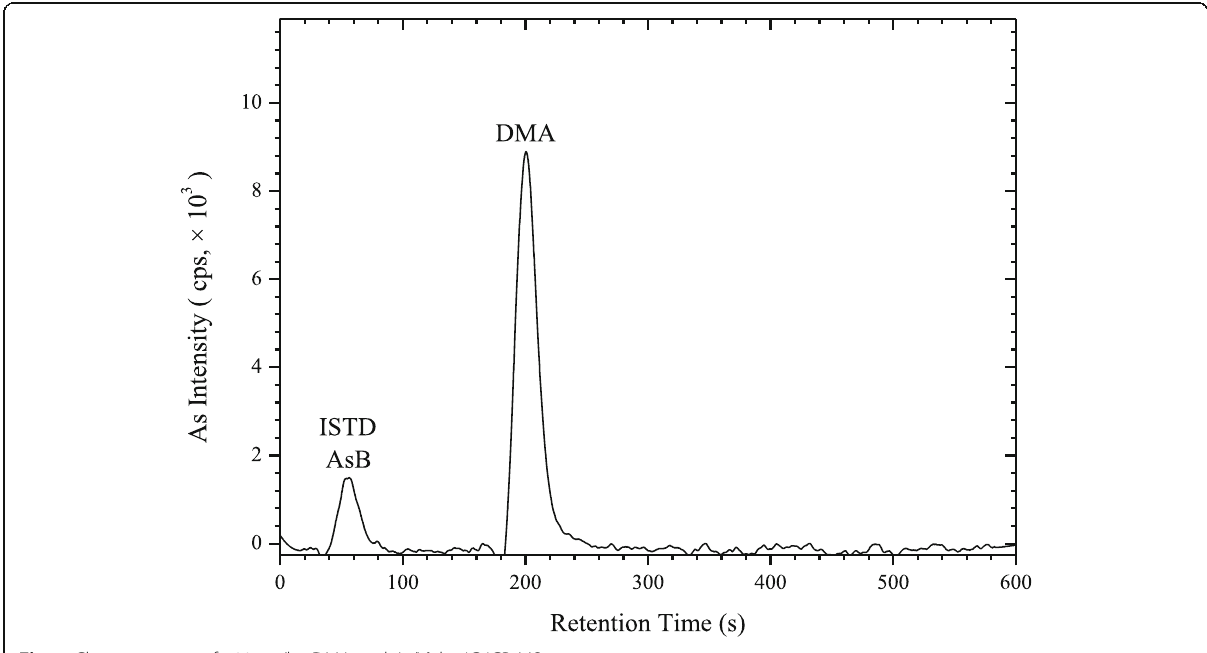
Fig. 4 Chromatogram of 100 μ g/kg DMA and As(V) by